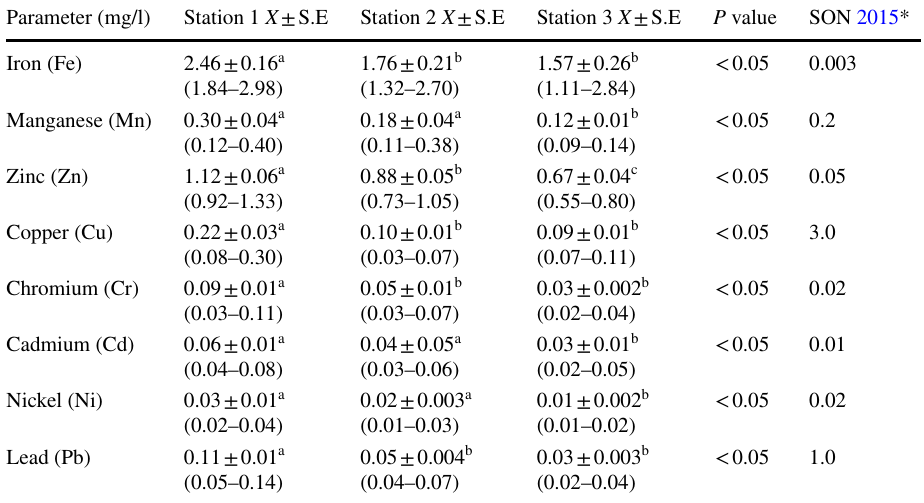
Table 3 Summary of heavy metals measured at Ossah River in Umuahia (with range in